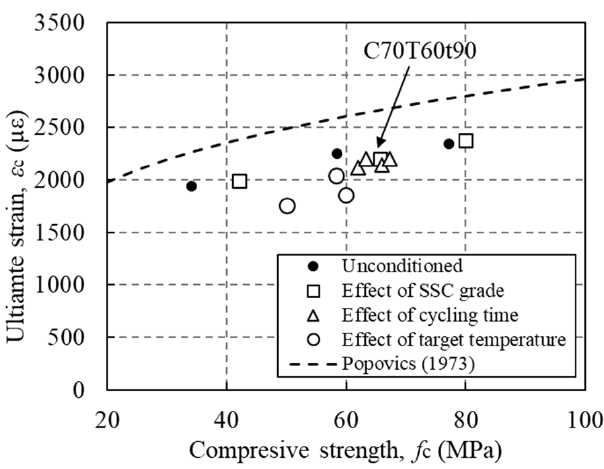
Figure 9. Ultimate strain of SSC.